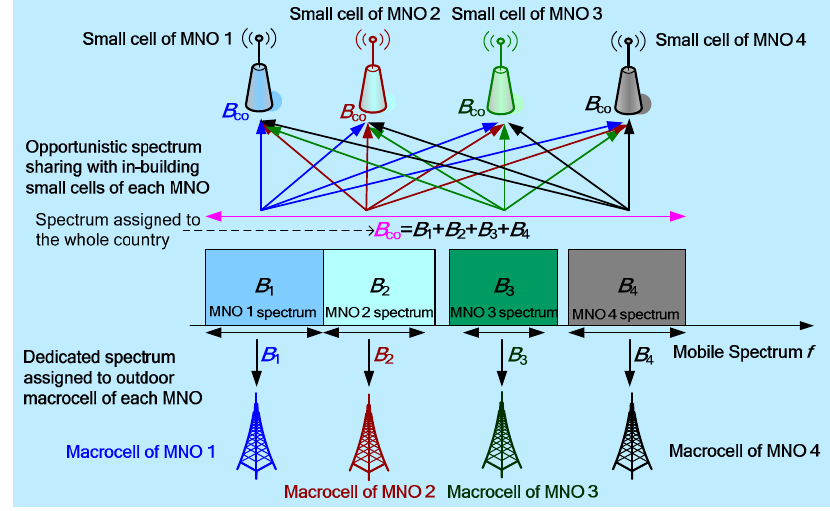
Figure 2. An abstract view of the proposed spectrum sharing technique for the maximum number of MNOs x m = 4 [12].